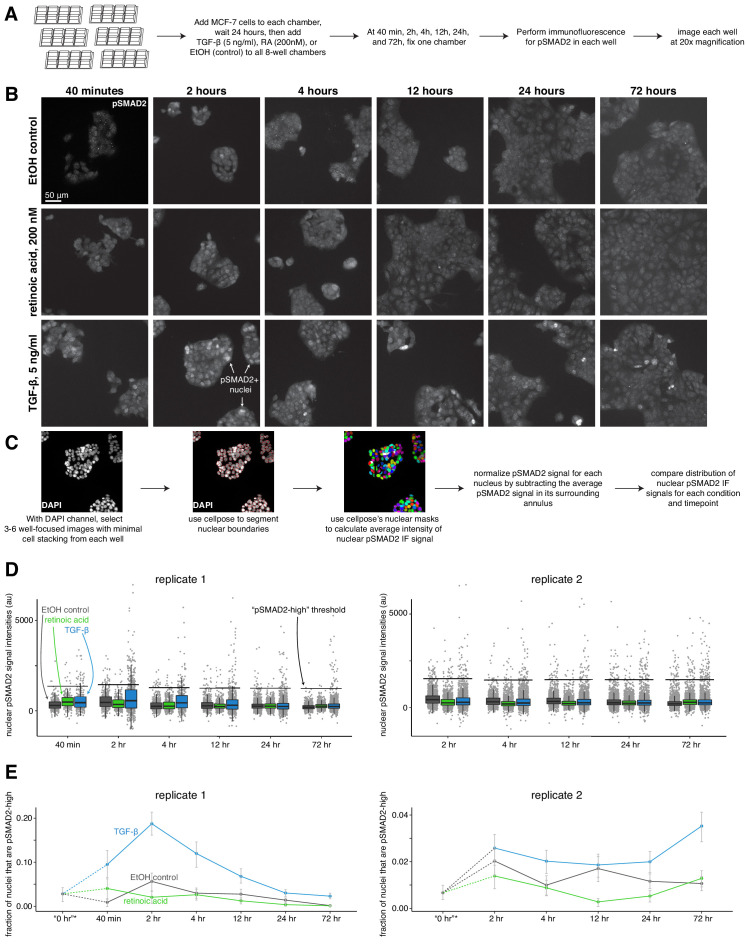
TGF-β, and not retinoic acid, leads to an increase in nuclear pSMAD2 levels in MCF-7 cells.(A) Schematic describing immunofluorescence experiment design. (B) Example images of pSMAD2 immunofluorescence for the medium dose of TGF-β, retinoic acid, or control cells at each time point. (C) Computational analysis workflow schematic, which describes how we use the cellpose segmentation algorithm in the DAPI channel to identify nuclear boundaries for measuring average nuclear signal intensity in the pSMAD2 immunofluorescence channel. (D) Summary statistics of normalized pSMAD2 nuclear intensity, where each point represents the average immunofluorescence signal intensity of one nucleus. Black horizontal bars used to define a ‘pSMAD2 high’ threshold are 1000 au above the median nuclear intensity value across all conditions in the same time point. (E) Fraction of cells that are pSMAD2-high across time for each condition, separated by replicate. *0 hr time point is a pseudo-time point that we generated from additional images taken in the control condition at the 40 min (replicate 1) or 2 hr time point (replicate 2).